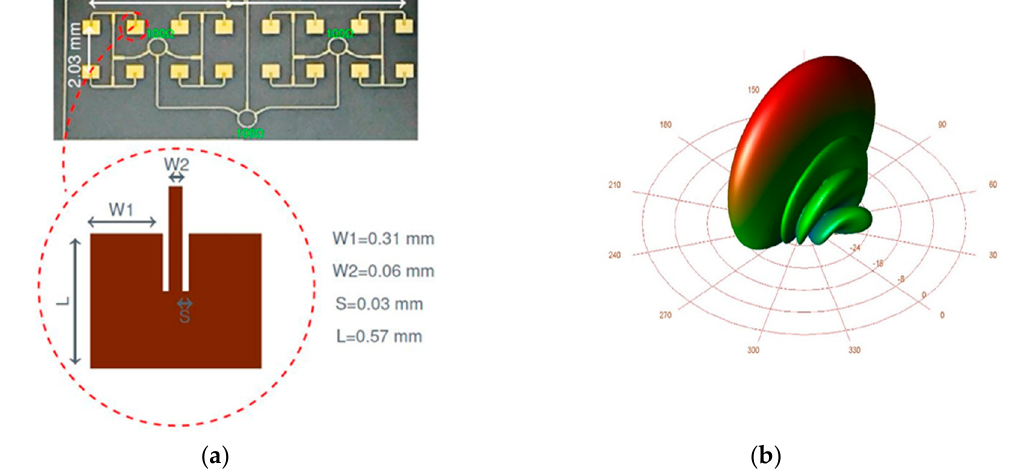
Figure 13. Microstrip antenna array: ( a ) layout; ( b ) simulated 3D radiation pattern.